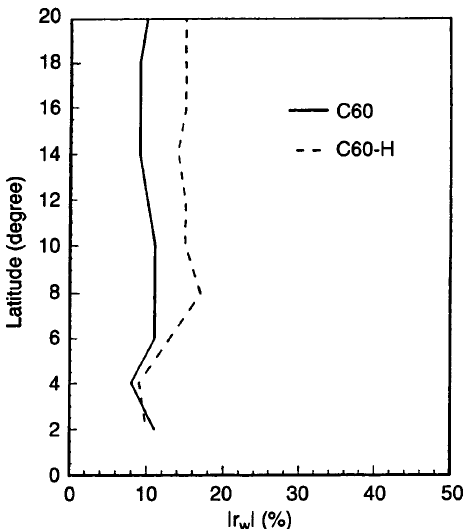
Fig. 7. Linear westward energy flux coe(cid:129)cient (%) at di(cid:128)erent latitudes ( (cid:14) ). Solid line for C60 and dashed line for C60-H. T (cid:136) 60 days